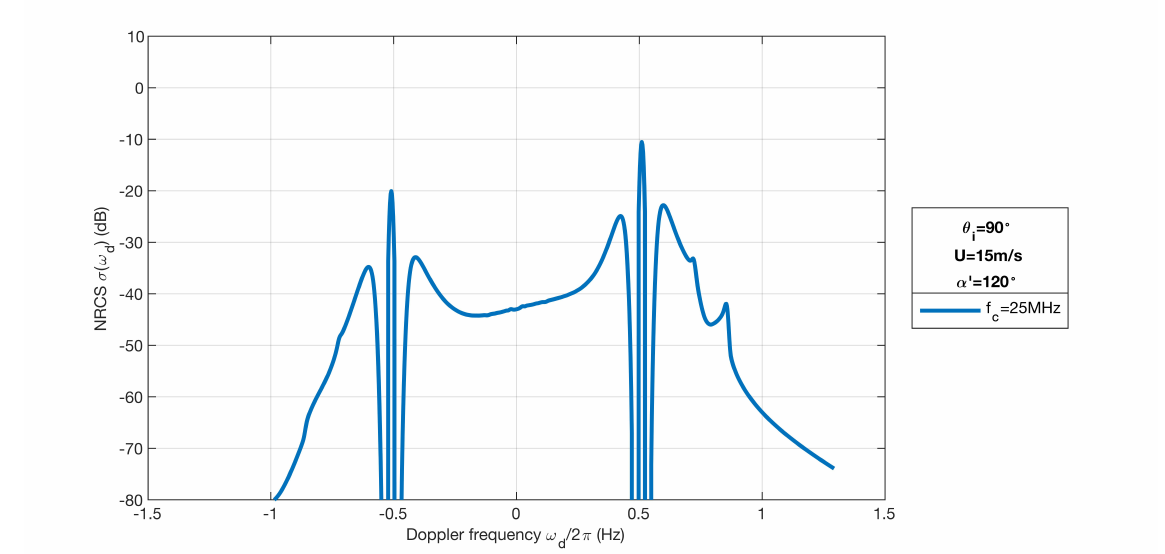
Figure 9. The simulated Doppler spectrum for monostatic radar ( θ i = 90 ◦ ). In order to compare the simulated result with Figure 5 in [36], U = 15 m/s, f c = 25 MHz and α (cid:48) = 120 ◦ were